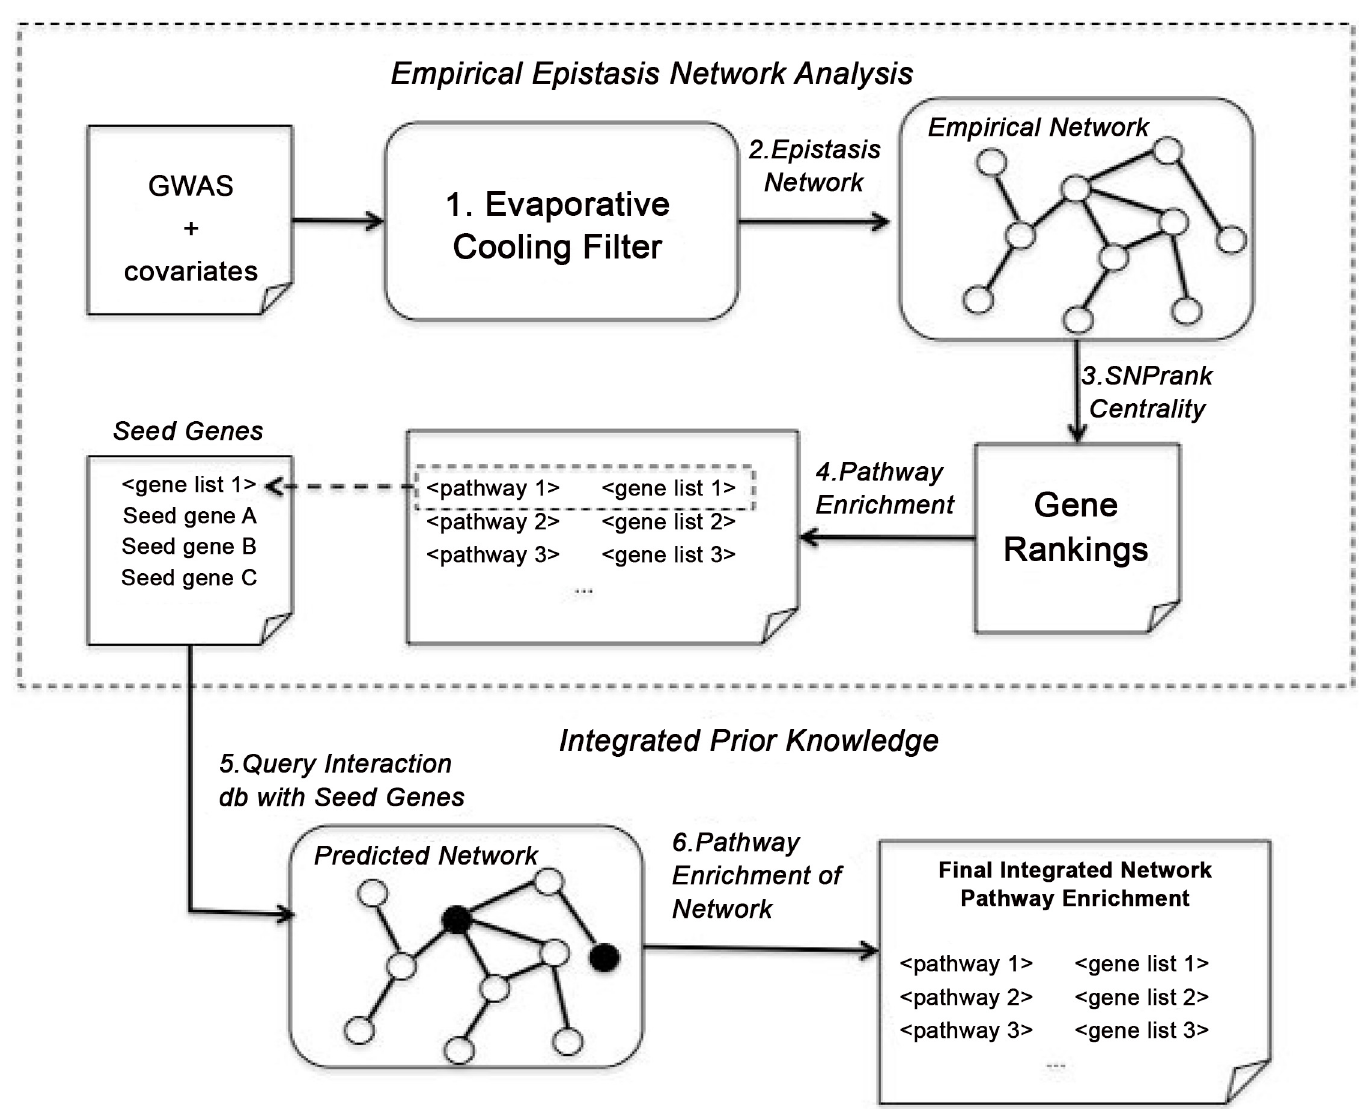
Fig 1. Integrative epistasis network analysis strategy. Simulated evaporative cooling (EC) feature selection is used to filter the top SNPs (1), which are used to compute a regression genetic association interaction network (reGAIN) of epistatic and main effects (2). The most important (hub) SNPs from the reGAIN are identified by their centrality with SNPrank (3). The top SNPs are mapped to genes and used to determine the most enriched Reactome pathways (4). The genes from the top pathway are used to query IMP for known functional interactions. Filled circles represent query genes and open circles represent predicted genes based on prior functional connectivity (5). The output is a posterior functional interaction network with enriched pathways (6).